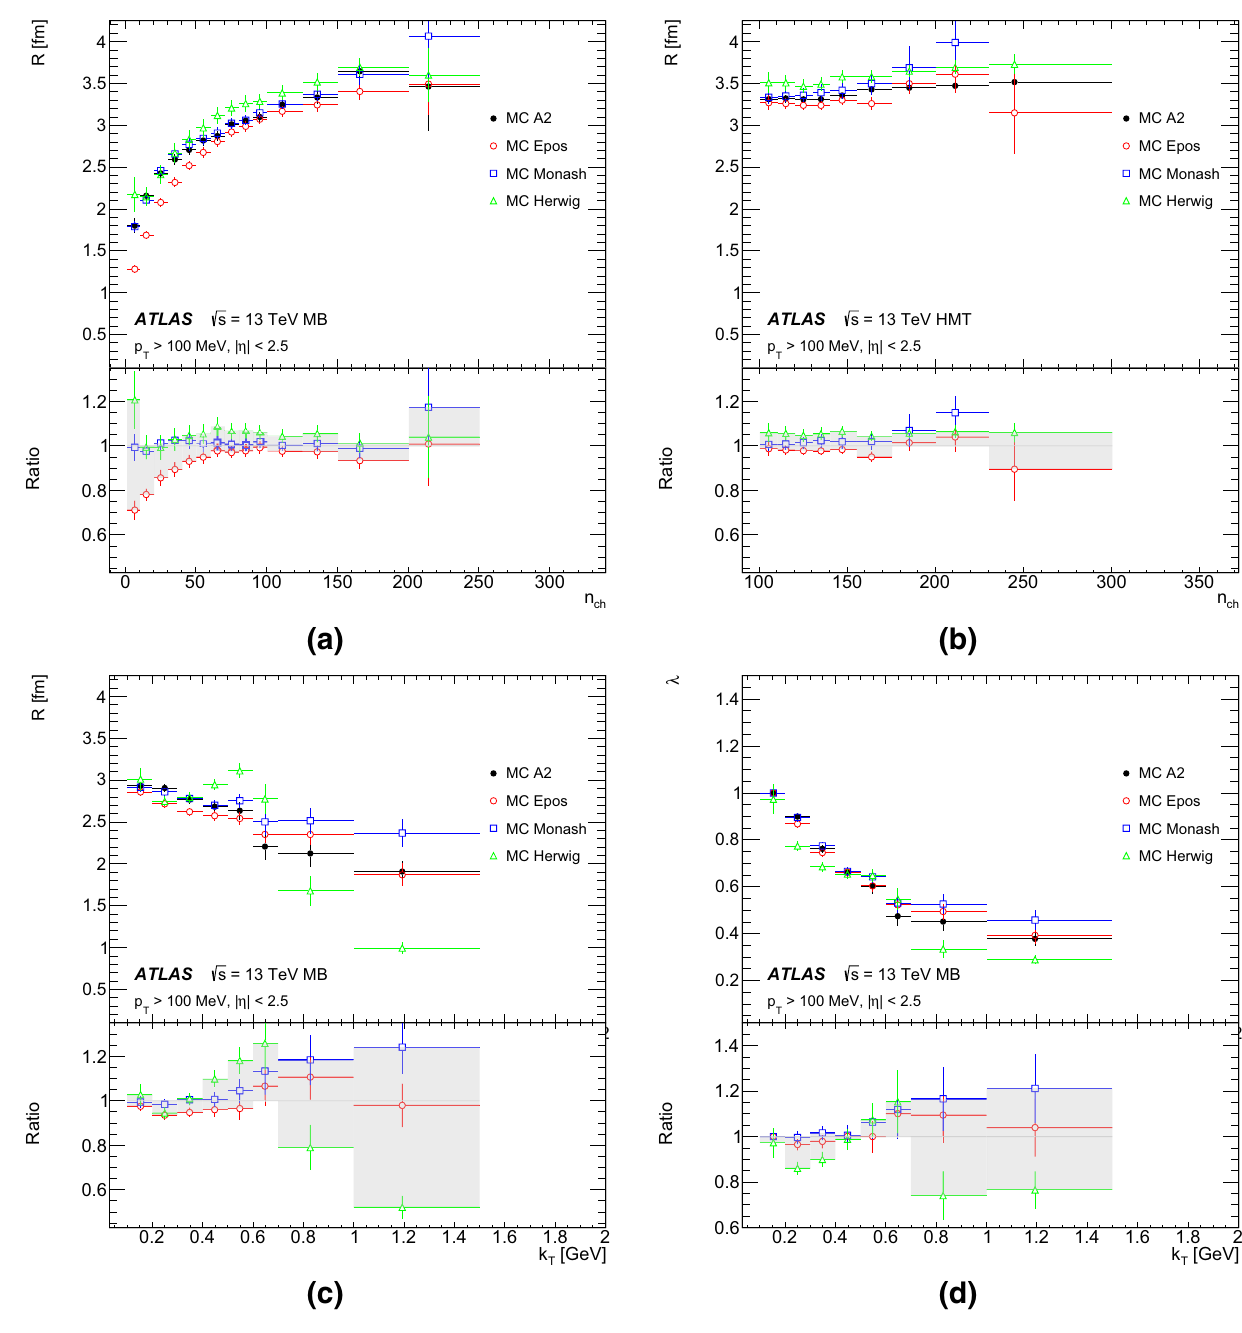
Fig. 2 The Bose–Einstein correlation (BEC) parameters λ and R as a function of n ch and k T using different MC generators in the calcu- lation of R 2 ( Q ) . a R versus n ch for MB events, b R versus n ch for HMT events, c R versus k T for MB events and d λ versus k T for MB events. The uncertainties shown are statistical. The lower panel of each